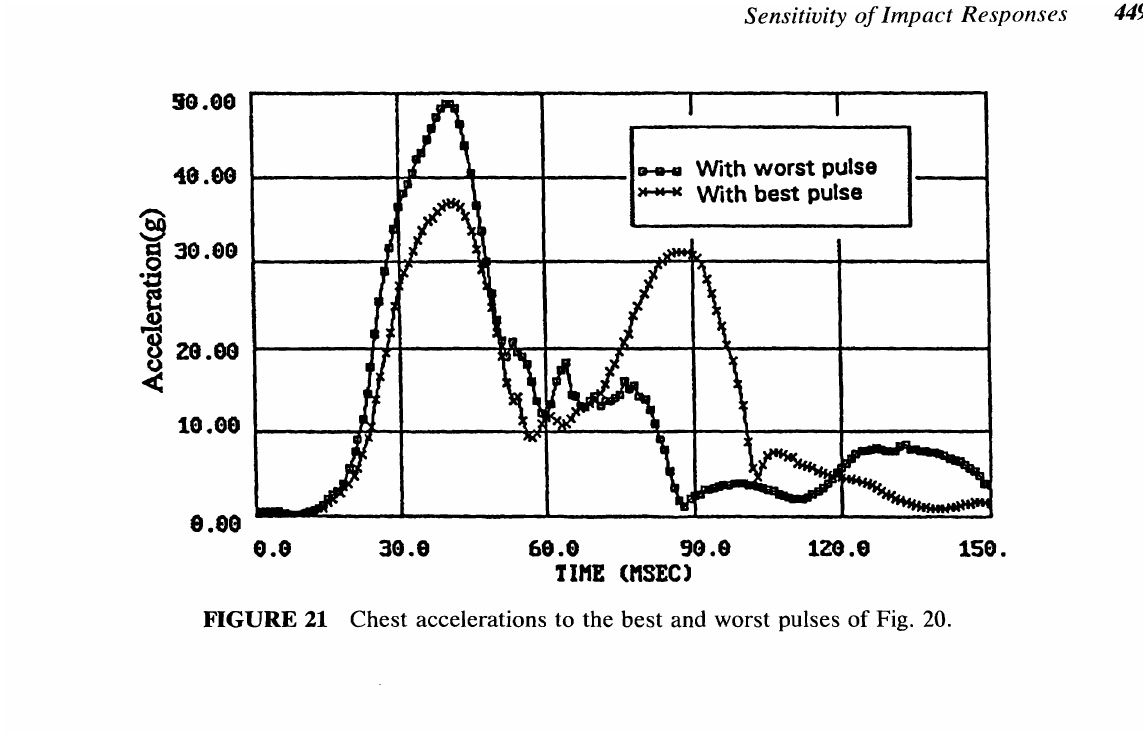
FIGURE 21 Chest accelerations to the best and worst pulses of Fig.